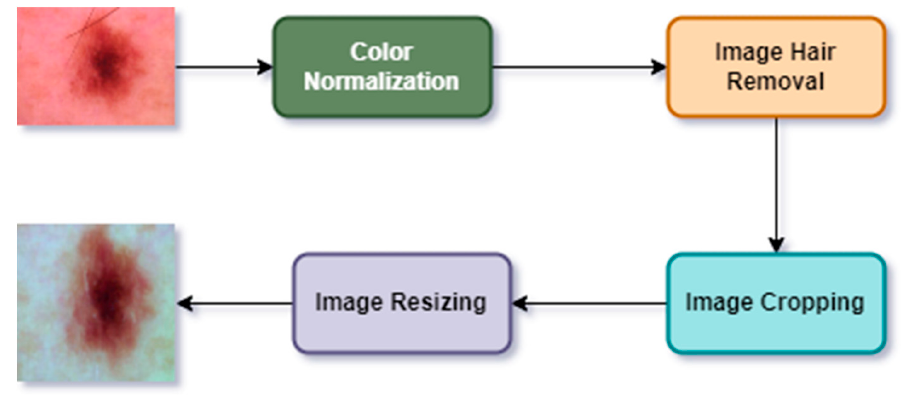
Figure 3. Image preprocessing steps.